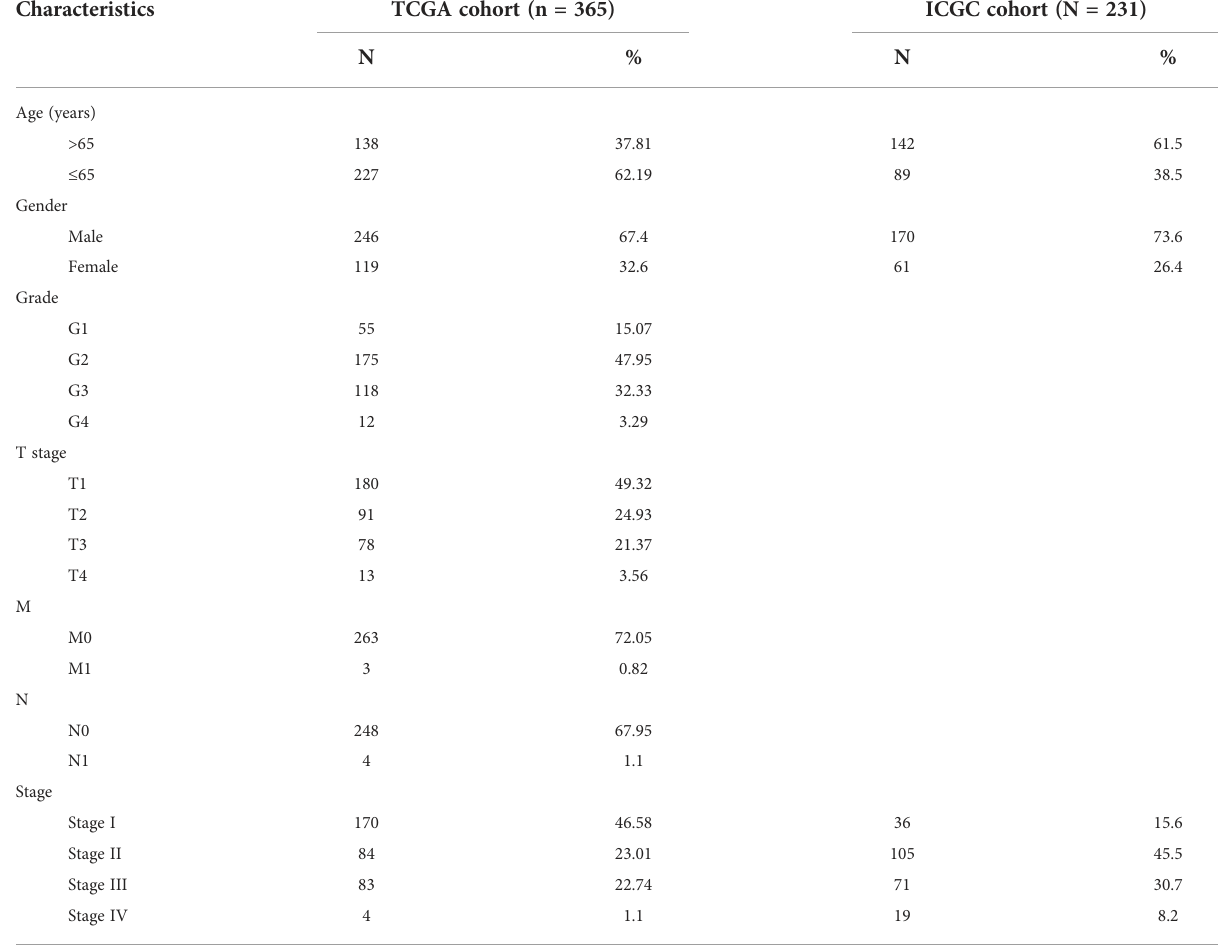
TABLE 1 Clinical features of the enrolled HCC patients.